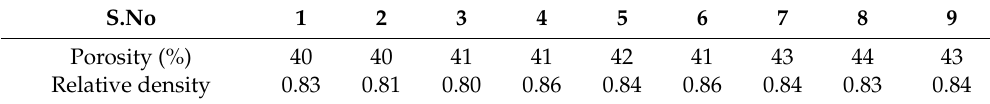
Table 5. Density and porosity of porous Al composites for nine sets of parameters.